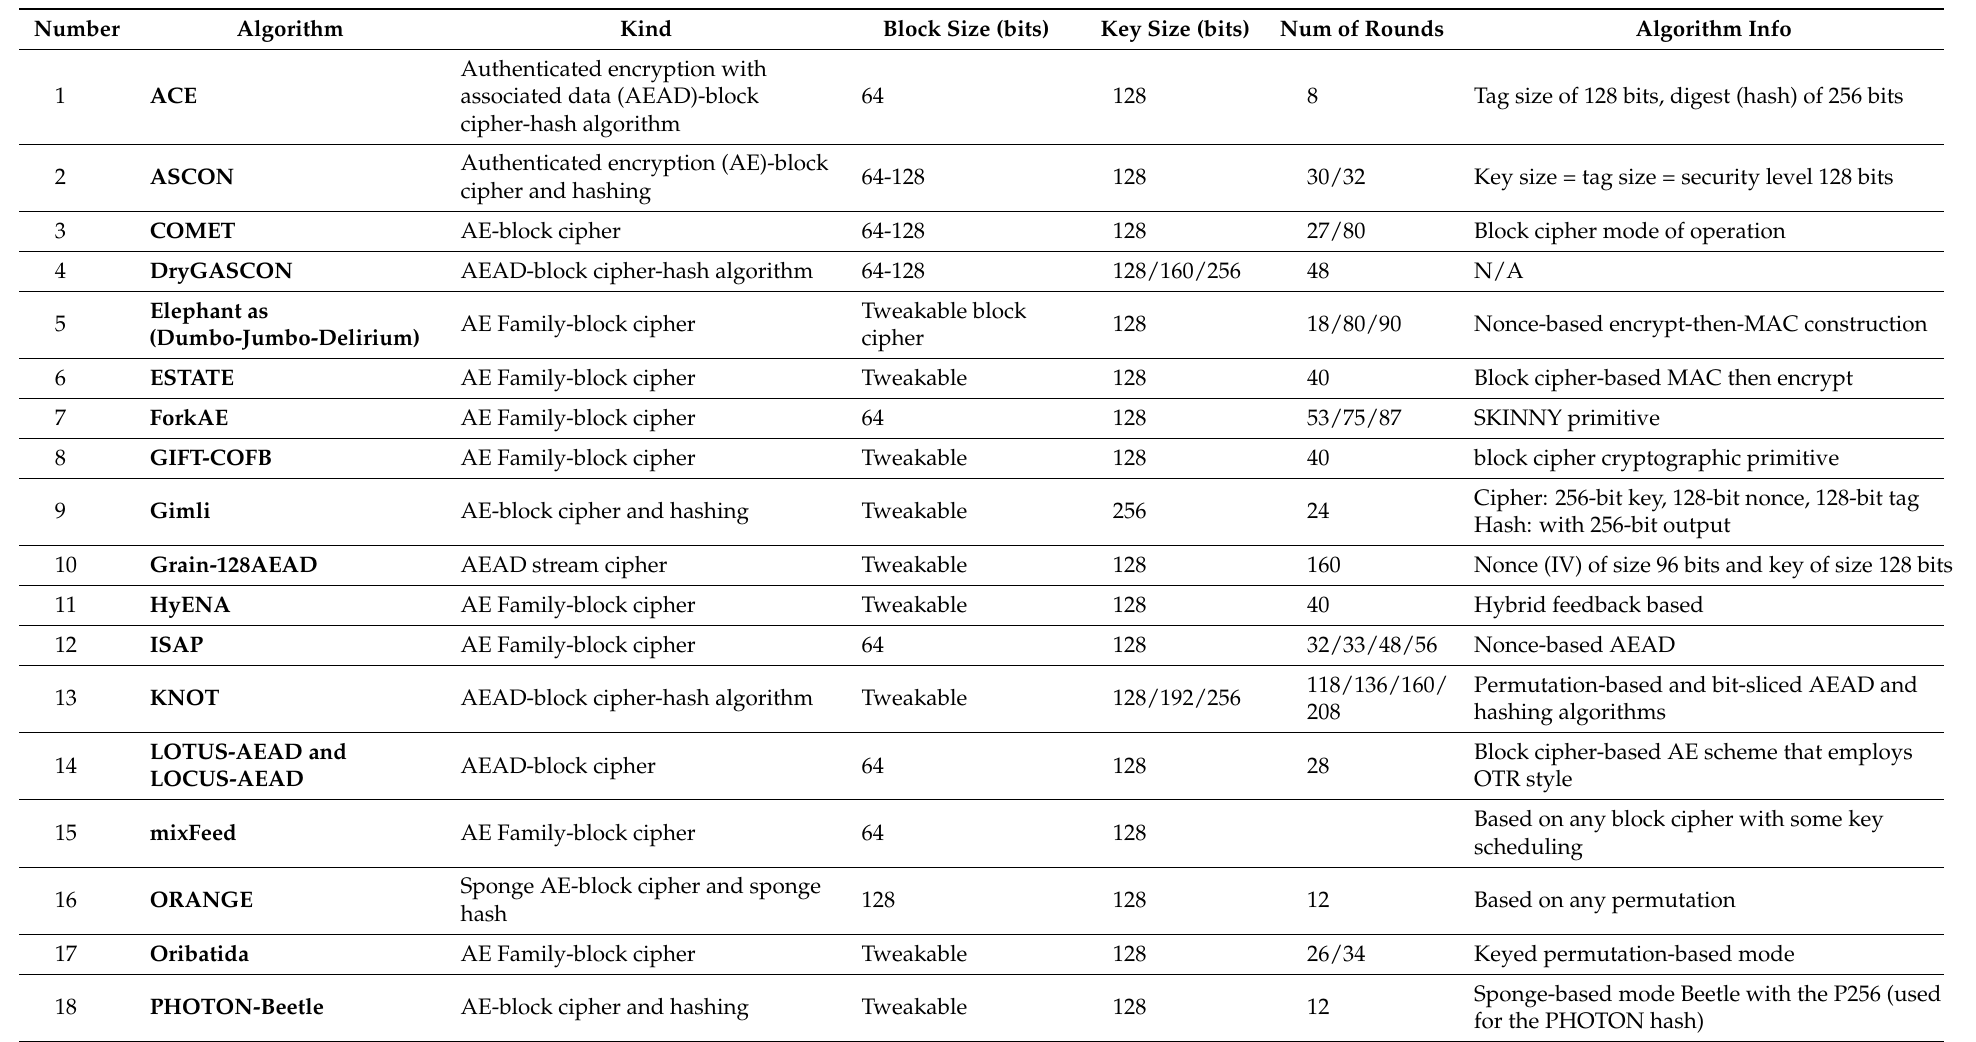
Table 2. NIST 2nd-Round Candidates, 32 families of 80